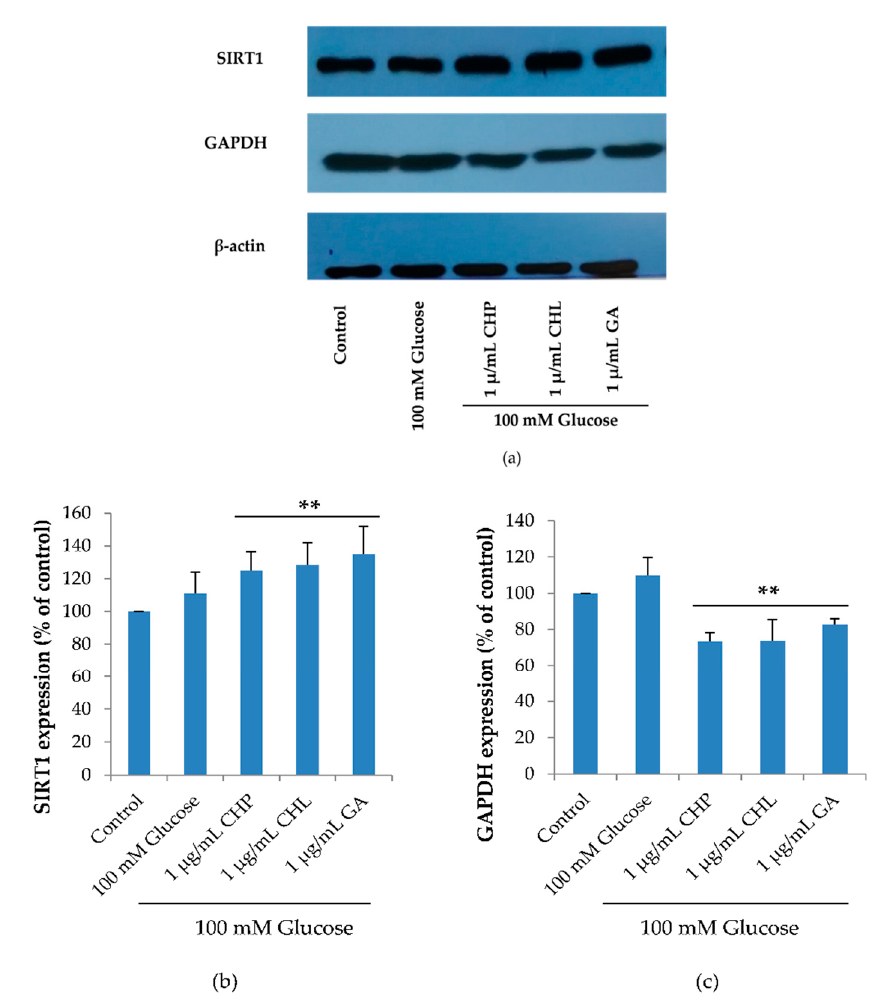
Figure 9. Surtuin 1 (SIRT1) and Glyceraldehyde 3-phosphate dehydrogenase (GAPDH) expression, as shown in a representative Western blot ( a ). Normalized values of SIRT1 and GAPDH against β -actin (( b ) and ( c )) . The mean ± SD values of normalized SIRT1 and GAPDH expression were obtained from three independent experiments, * p < 0.05 vs. control; ** p < 0.05 vs. 100 mM glucose alone. For SIRT1, p values were 0.005, 0.011 and 0.005 for CHP, CHL and GA, respectively. For GAPDH, p values were 0.001, 0.001 and 0.008 for CHP, CHL and GA, respectively.